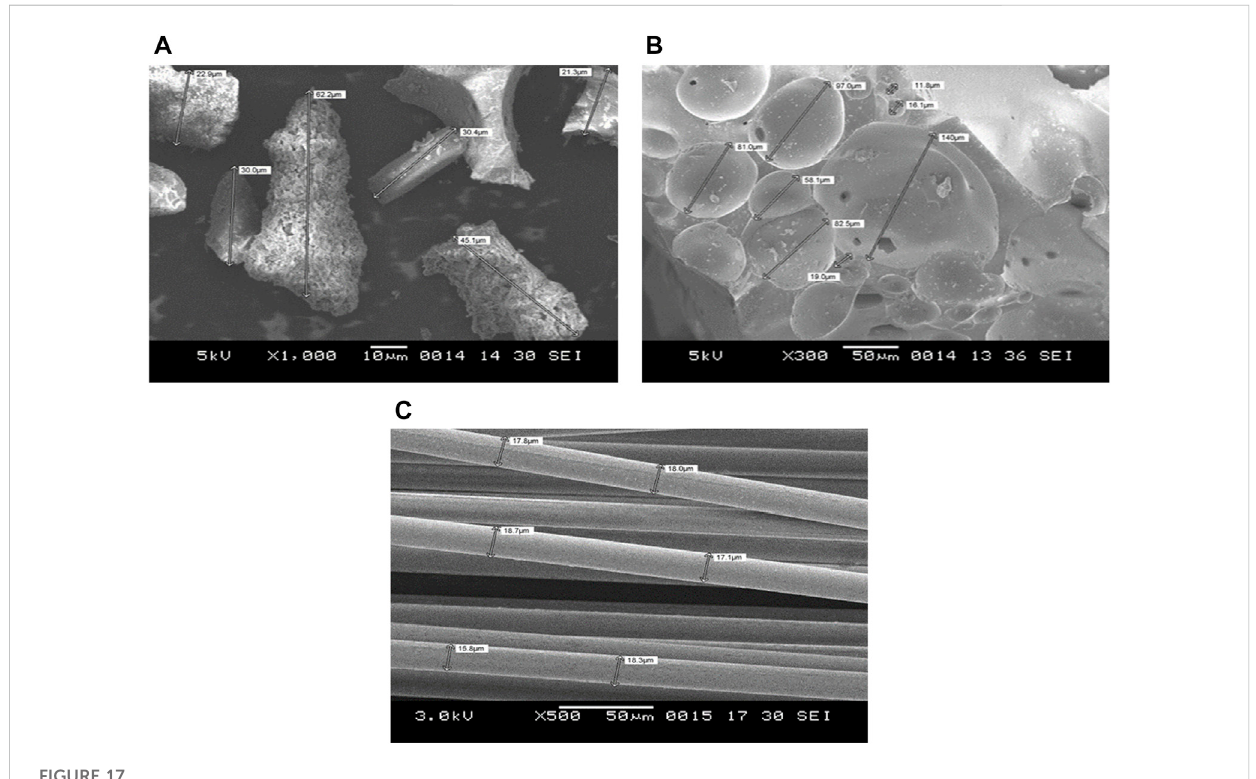
FIGURE 17 Microstructures of (A) SBCA; (B) BFS; (C)